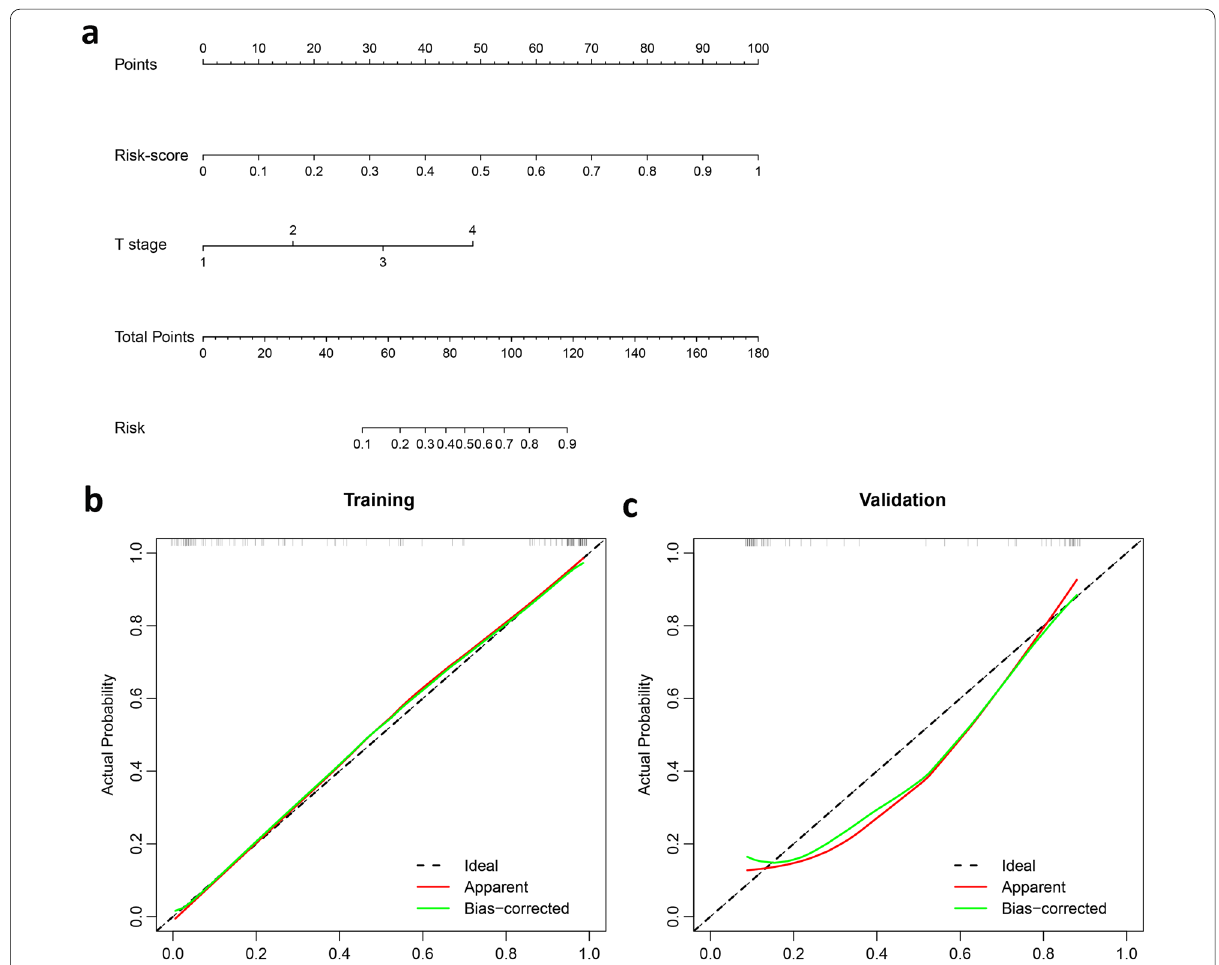
Fig. 2 Nomogram and calibration curves. a A nomogram was developed in training cohort, with Rad-score and T stage incorporated. Calibration curves of the nomogram in ( b ) training and ( c ) validation